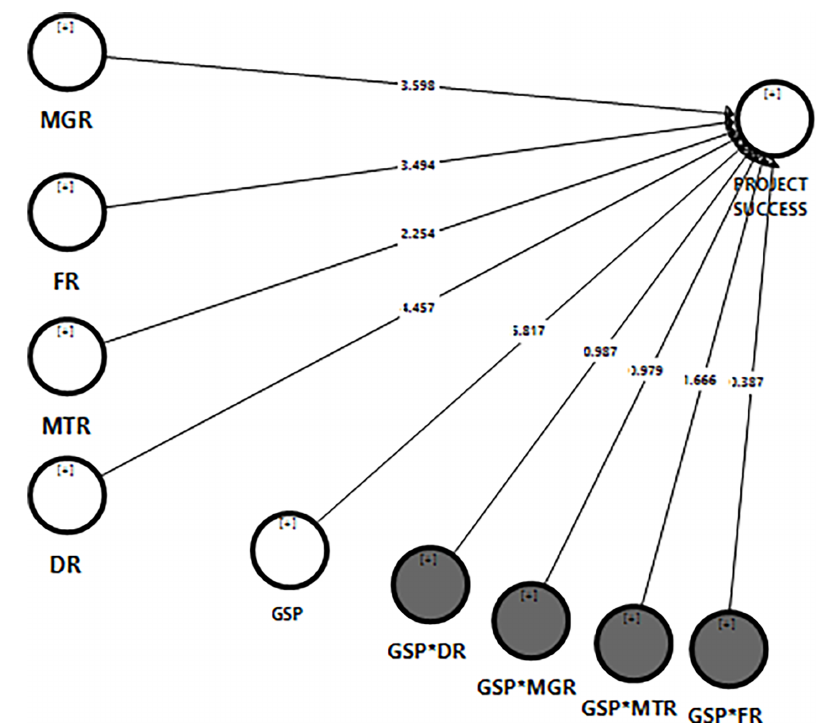
Figure 3. Structural model indicating the significance of product terms